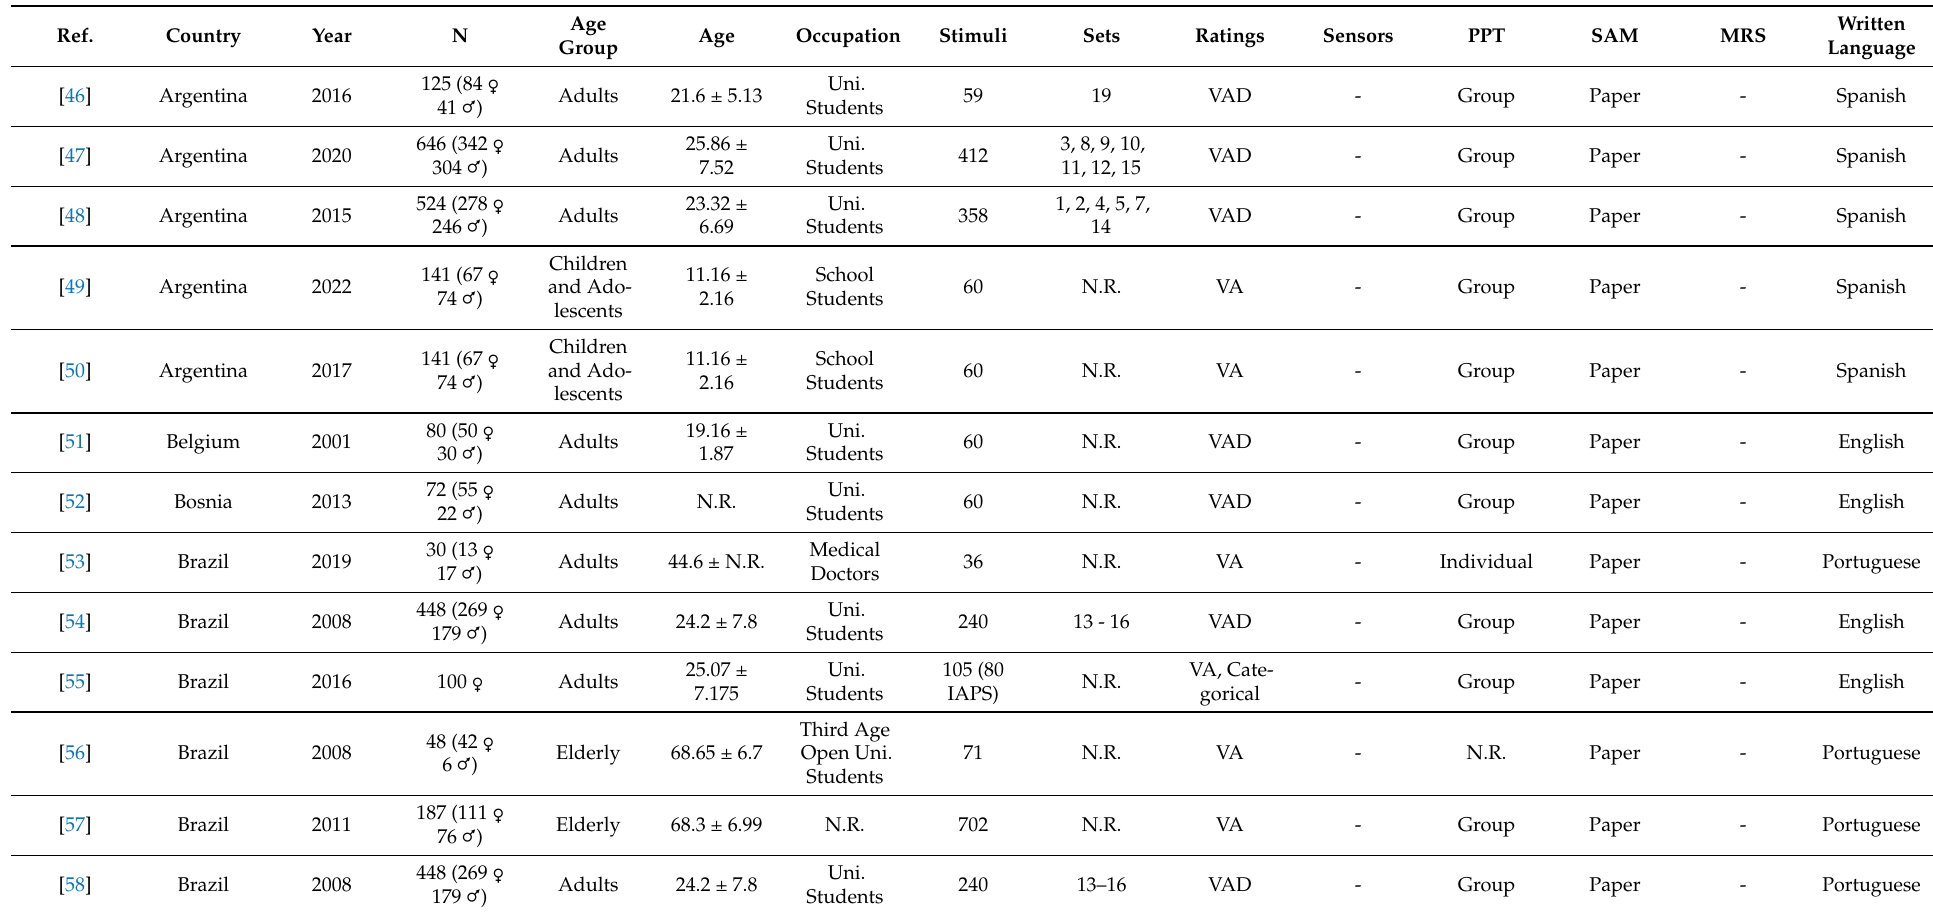
Table 1. Overall characteristics of studies included in Systematic Review. Abbreviations: Arousal (A), Bivariate Evaluation and Ambivalence Measures (BEAMs), Electroencephalography (EEG), Electromyography (EMG), Heart-Rate Variability (HRV), Modified Rating Scale (MRS), Not Applicable (N.A.), Not Reported (N.R.), Picture